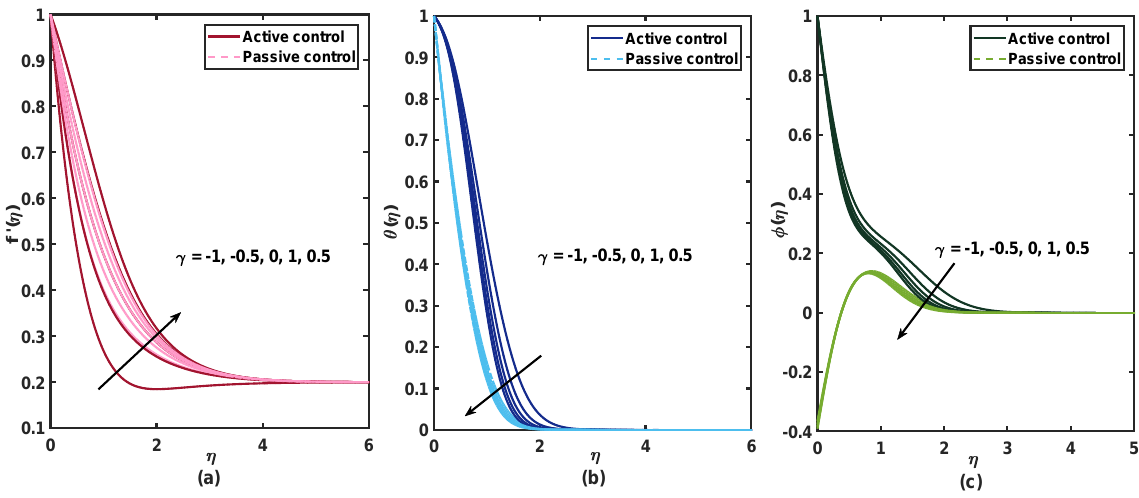
Figure 5. Impact of mixed convection parameter γ on ( a ) velocity, ( b ) temperature, and ( c ) nanoparticle volume fraction